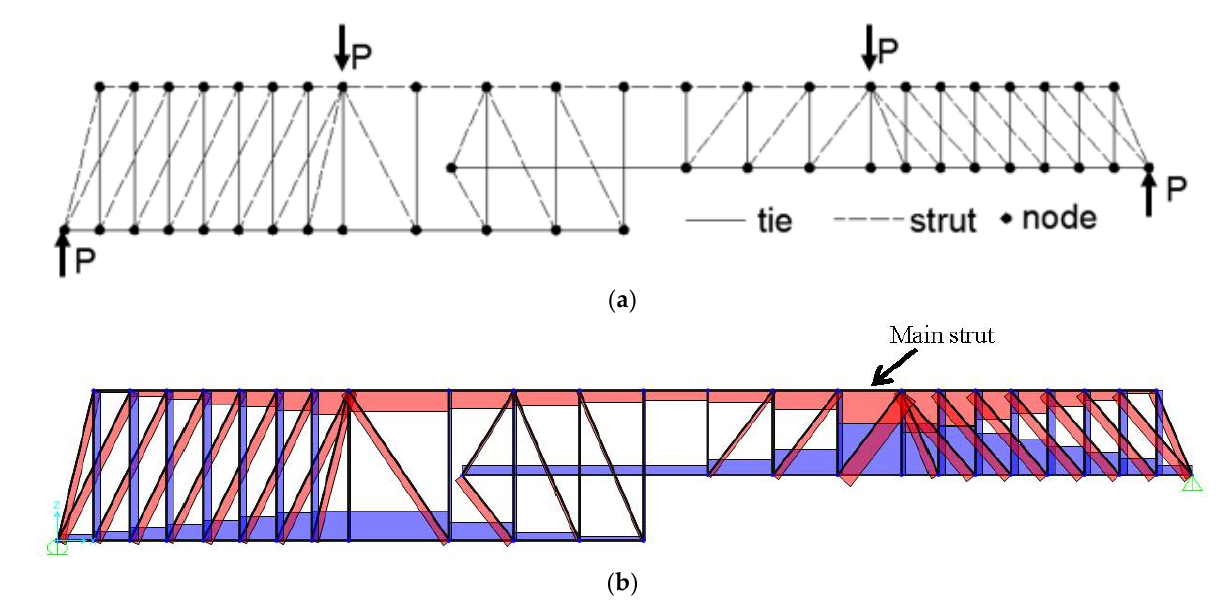
Figure 23. The solution of B4: ( a ) The proposed STM and ( b ) The force diagram of struts and ties.